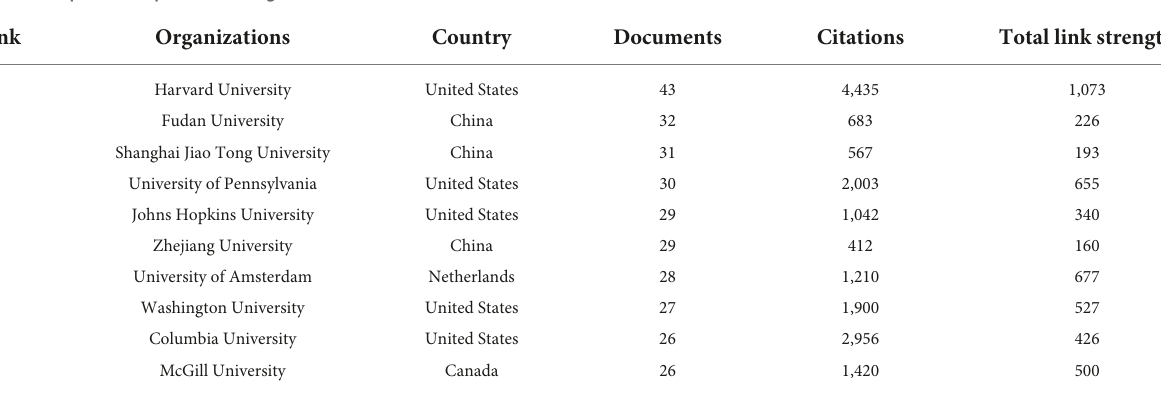
TABLE 2 Top 10 most productive